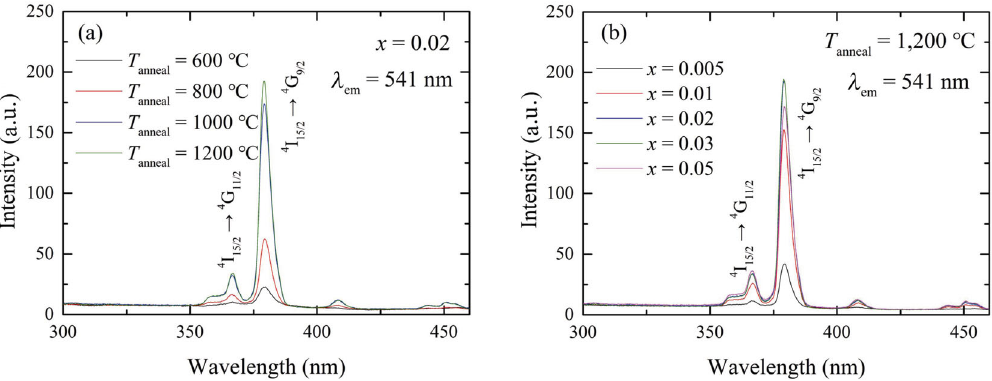
Fig. 4 (a) PLE spectra of the x = 0.02 NCs annealed at T anneal ( T anneal = 600, 800, 1000, and 1200 ℃ ) and (b) PLE spectra of the x = 0.005, 0.01, 0.02, 0.03, and 0.05 NCs annealed at 1200 ℃ , obtained by monitoring the emissions at λ em = 541 nm.